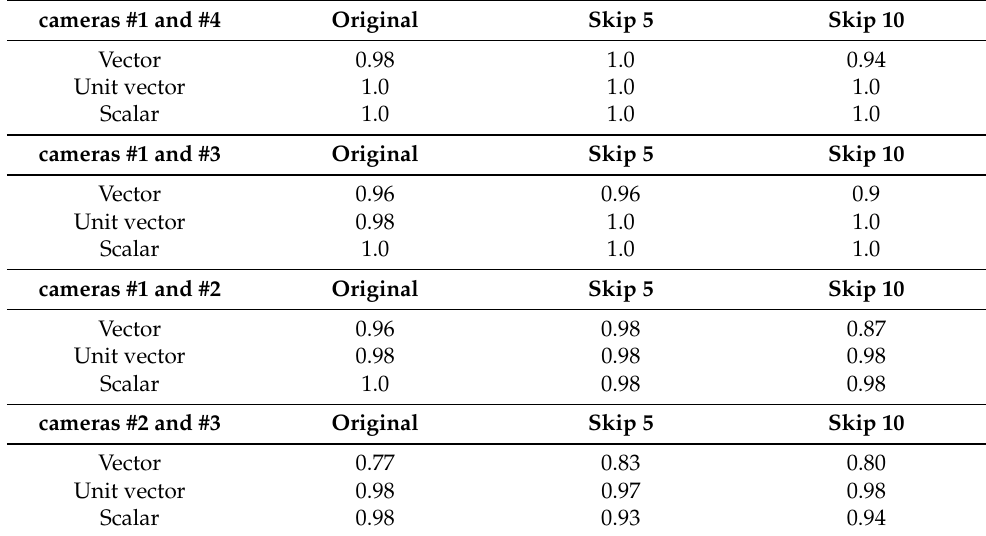
Figure 6. Global ID matching results for three targets in several overlapping FOV indoor scenarios with two cameras: ( a ) cameras #1 and #4, ( b ) cameras #1 and #3, ( c ) cameras #1 and #2, and ( d ) cameras #2 and #3. Table 2. F1 score for global tracklet matching in cameras 2 and 3 FOV